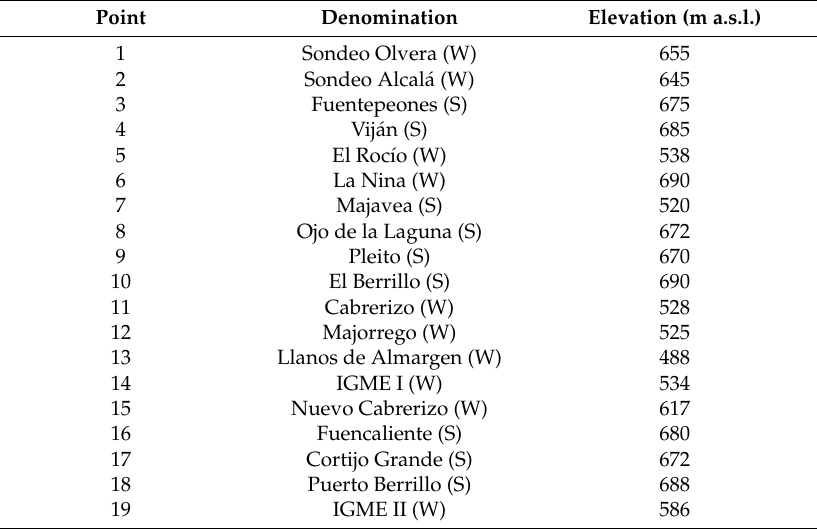
Table 1. Hydro-chemical and isotopic sampling